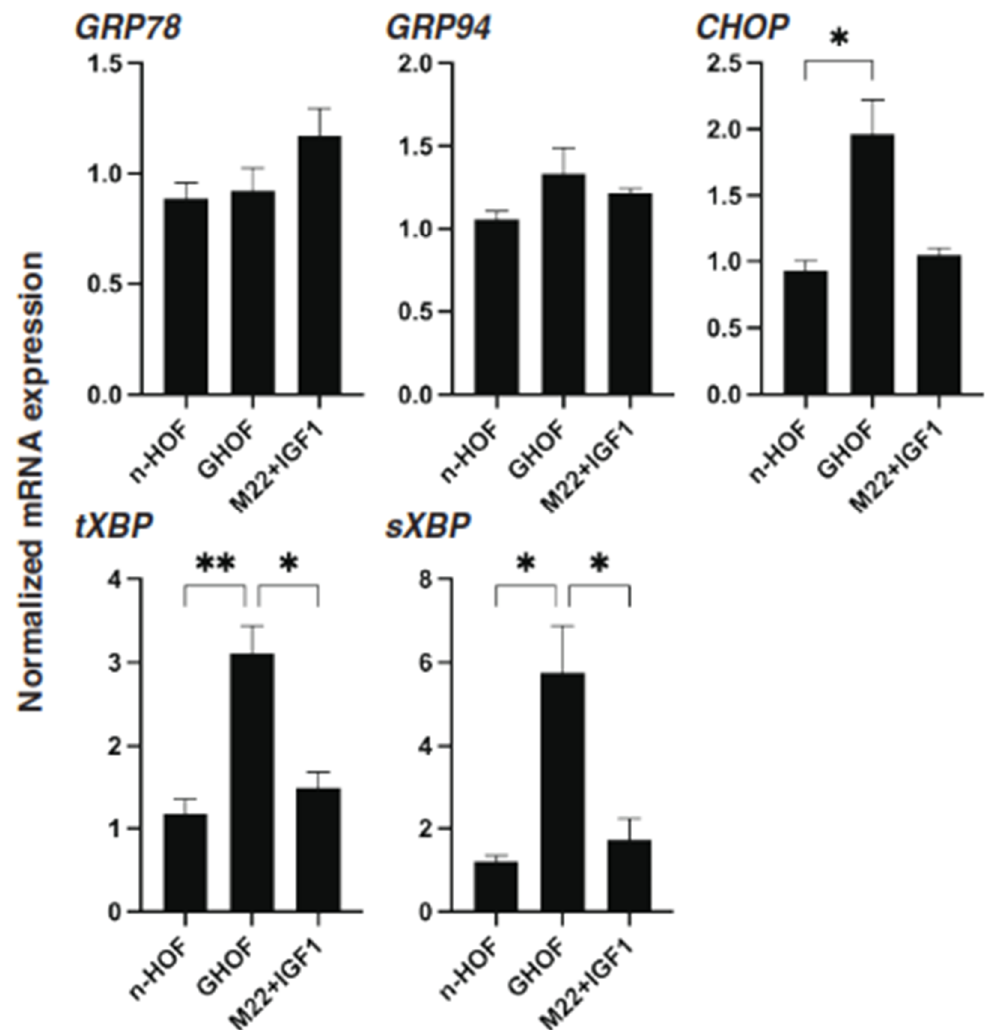
Figure 7. mRNA expression of ER stress-related genes among n-HOF-, GHOF- and M22/IGF-1-treated n-HOFs 3D spheroids. At Day 6, n-HOF-, GHOF- or 10 ng/mL M22/100 ng/mL IGF-1-treated n-HOFs 3D spheroids were subjected to a qPCR analysis to estimate the mRNA expression of ER stress-related genes, including major ER stress-related genes of the inositol-requiring enzyme 1 (IRE1), glucose regulator protein (GRP)78, GRP94, the X-box-binding protein-1 (XBP1), spliced XBP1 (sXBP1) and CCAAT/enhancer-binding protein homologous protein (CHOP). All experiments were performed in duplicate using fresh preparations, each of which consisted of 16 spheroids. Data are presented as the arithmetic mean ± standard error of the mean (SEM). * p < 0.05, ** p < 0.01 (ANOVA followed by a Tukey’s multiple comparison test).